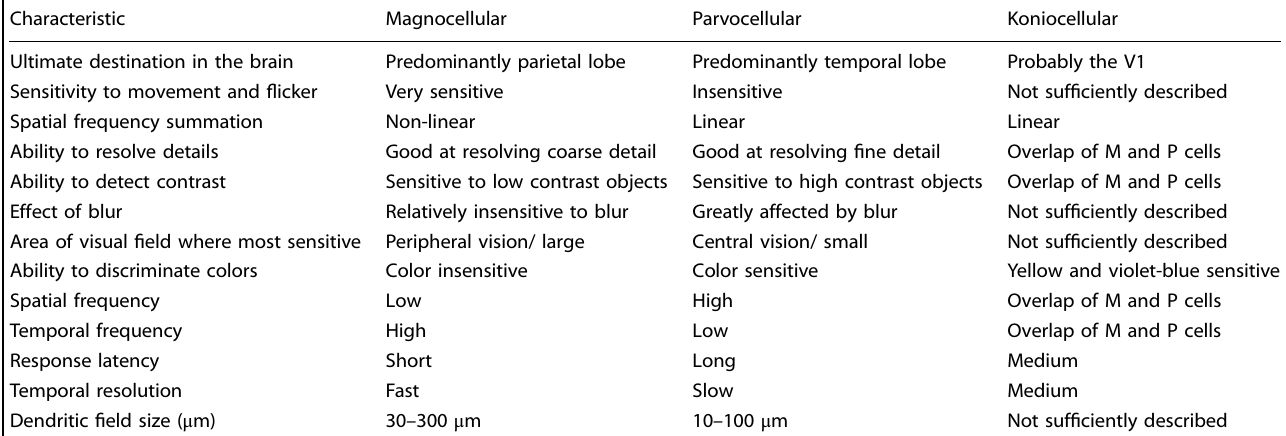
Table 1. Morphological and functional characteristics of the visual